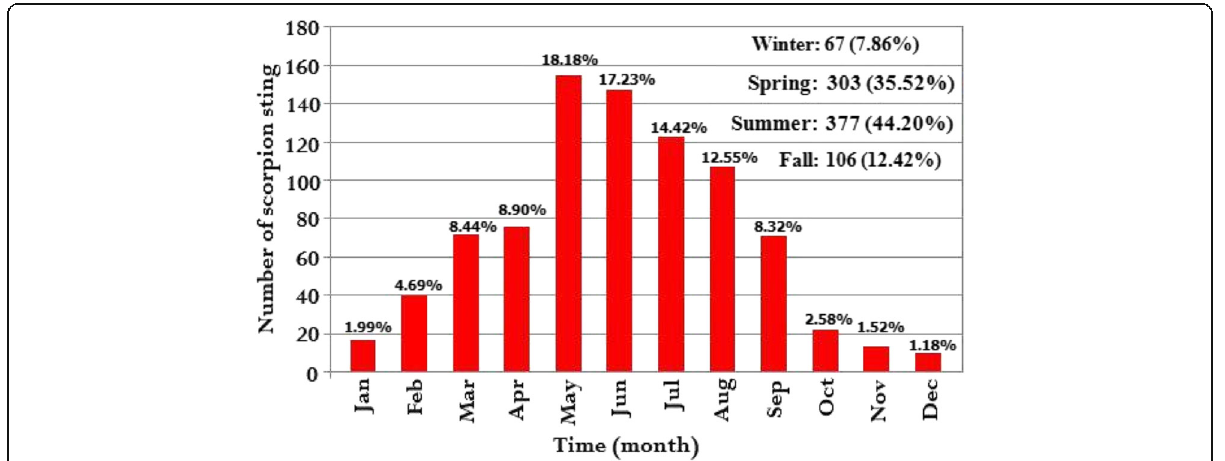
Fig. 2 Distribution of scorpion sting cases based on various months and seasons in the city of Haji-Abad, from 2012 to 2016 ( n = 853)